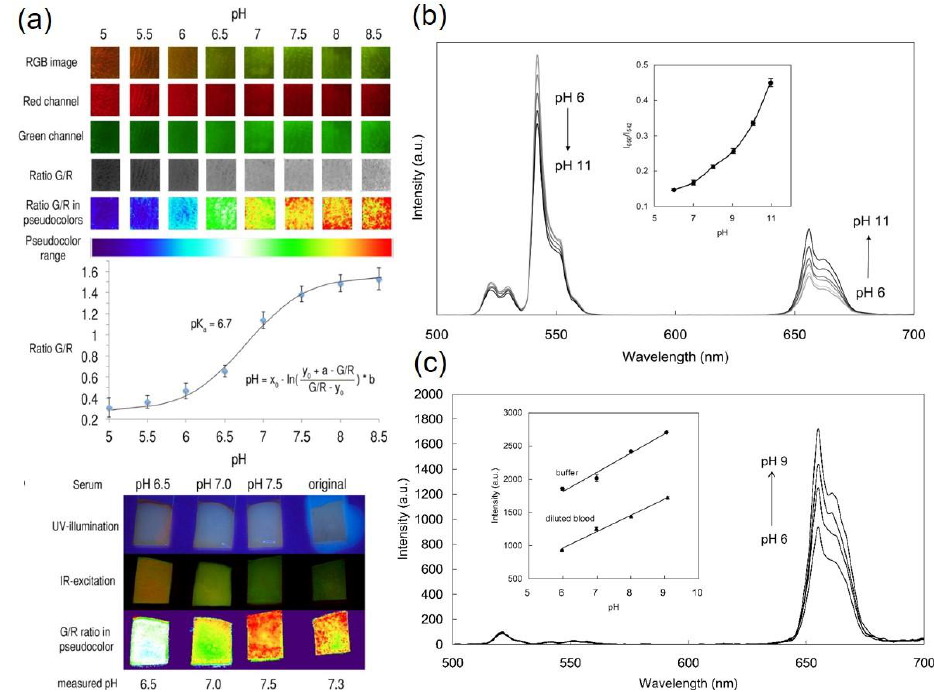
Figure 5. ( a ) Imaging calibration row (RGB) of the membrane. The graph at the middle of ( a ) shows the ratio G/R values versus the pH for calibration point. At the bottom, four sensor spots were impregnated with serum specimens. The first three samples have adjusted pH values at pH 6.5, pH 7.0, and pH 7.5 and the fourth one is original. Autofluorescence from background is seen under UV illumination (first row). IR excitation and RGB imaging of the real serum samples remains unaffected from the background (second row). The G/R ratio is shown in pseudocolor (bottom row) and converted into corresponding pH values (Adapted with permission from Ref. [76]. Copyright (2014) American Chemical Society.). ( b ) The 980 nm excited upconversion spectra of the pH-sensor film containing UCNPs (NaYF 4 ; Er 3+ /Yb 3+ ) and chromoionophore (ETH 5418), within pH values 6–11. Inset shows intensity ratio of 656 nm to 542 nm emission band as a function of pH; ( c ) Upconversion spectra of the pH-sensor film containing UCNPs and ETH 5418 in diluted blood. Inset shows the intensity variation of 656 nm emission band of sensor film in buffer and diluted blood as a function of pH (Figure 5b,c: Adapted with permission from Ref. [84]. Copyright (2012) American Chemical